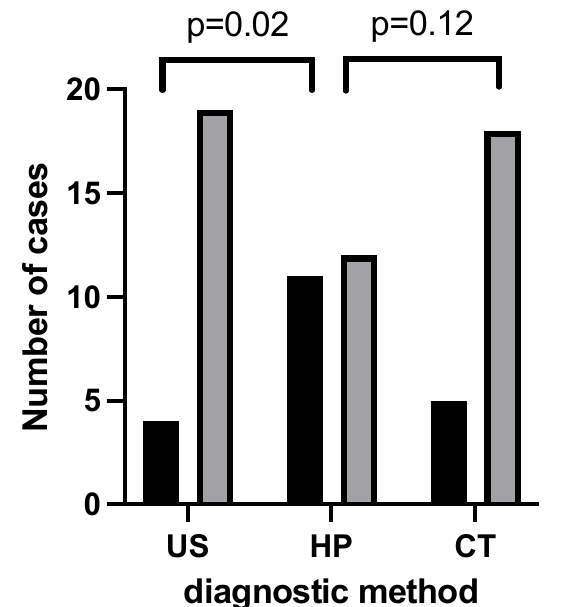
8 of 12 Table 2. Chi square analysis (US = ultrasound, TC = computed tomography, IO = intraoperatively). US Percentage and Number of Detec-